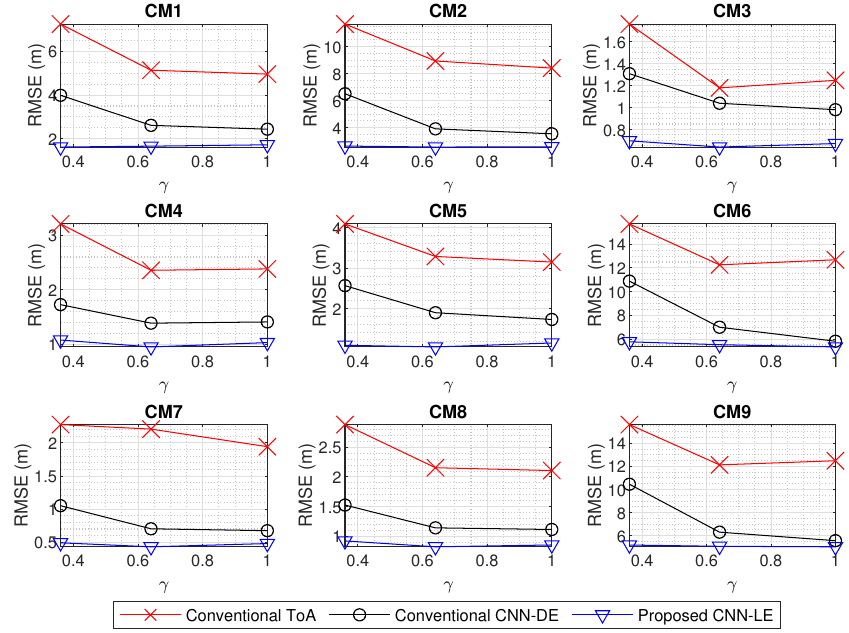
Figure 11. RMSE ( y -axis) across the γ ( x -axis) for an area of 225 m 2 . CM# data is used for both training and test.